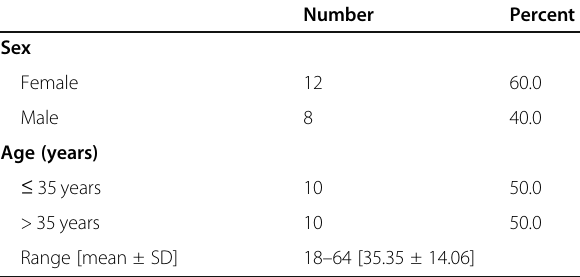
Table 3 Demographic data distribution of the study group